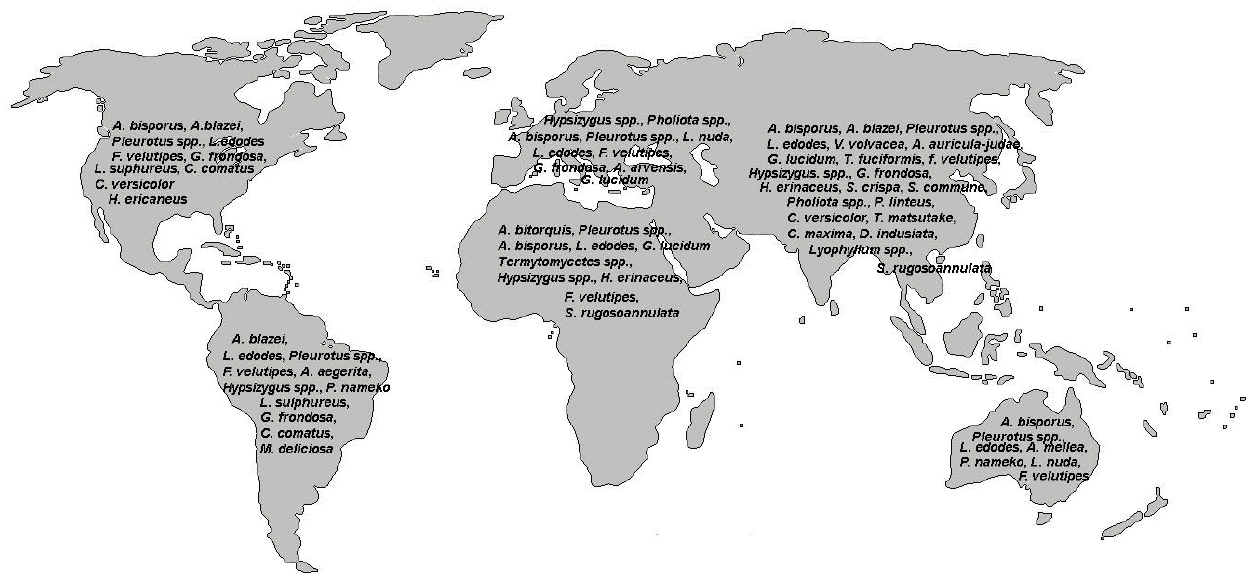
Figure 1. Map of edible mushroom species that are commonly grown commercially all over the